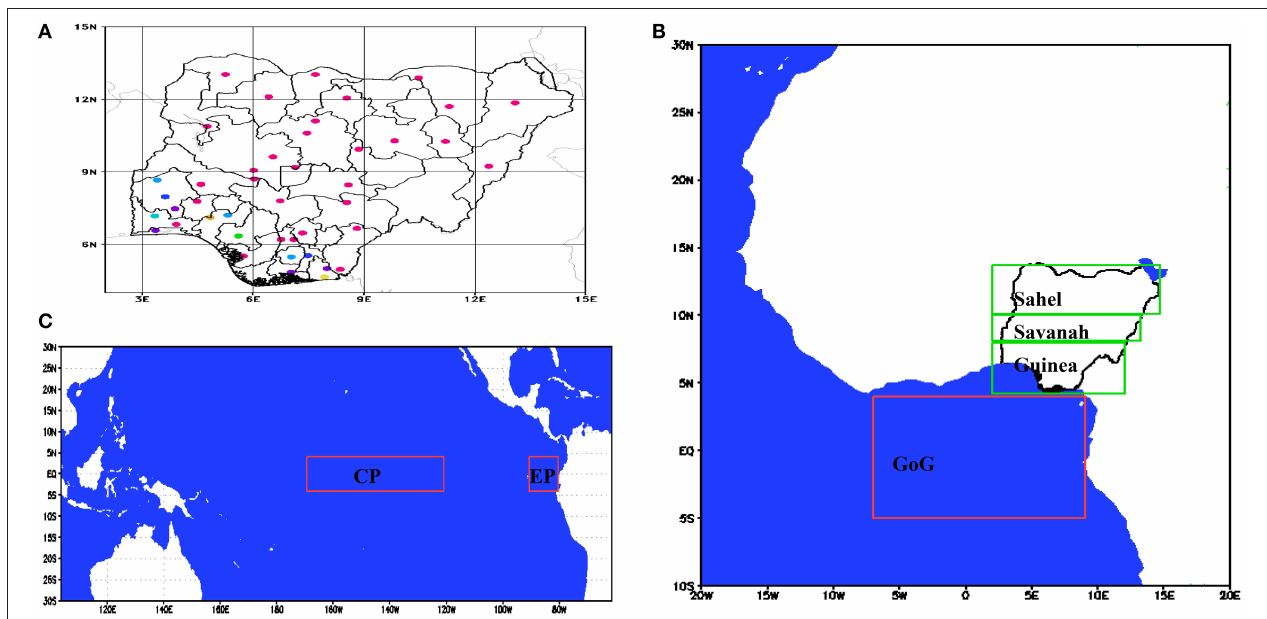
FIGURE 1 | Maps showing (A) locations of synoptic stations used in this study (source: Olaniyan et al., 2015); (B) three climatological zones in Nigeria in (green boxes) and defined area of the Gulf of Guinea(GoG) over the Atlantic Ocean in (red box); and, (C) defined Areas of the Central and Eastern Pacific ocean in red